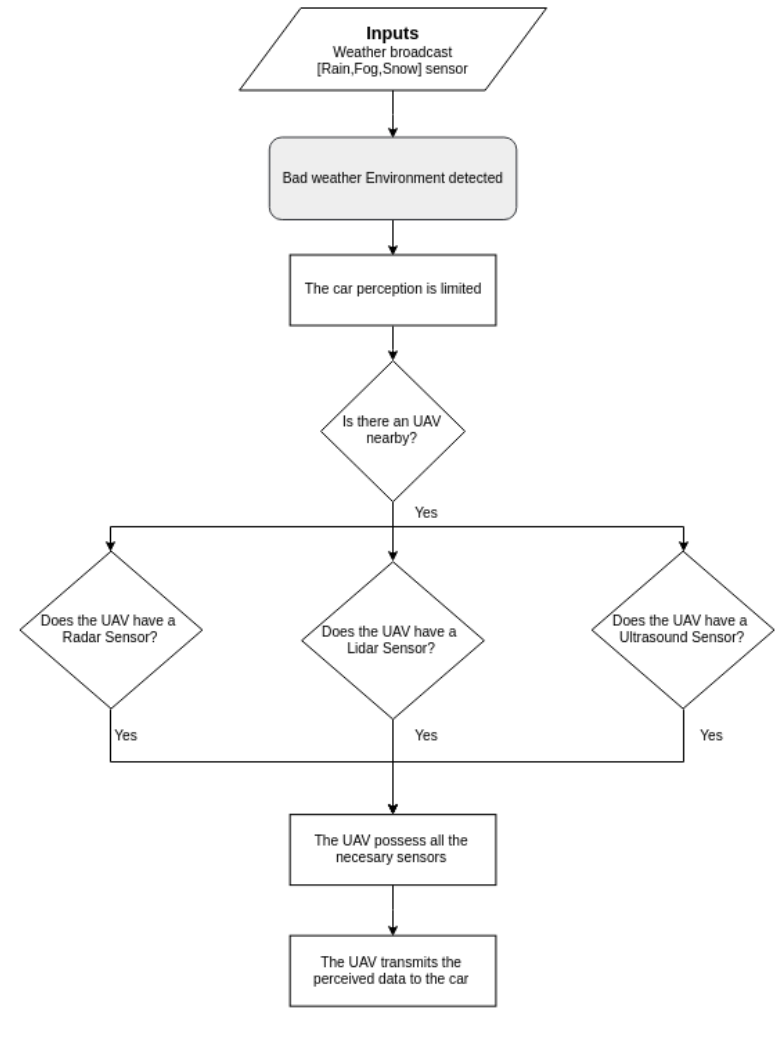
Figure 7. Flowchart of the reasoning